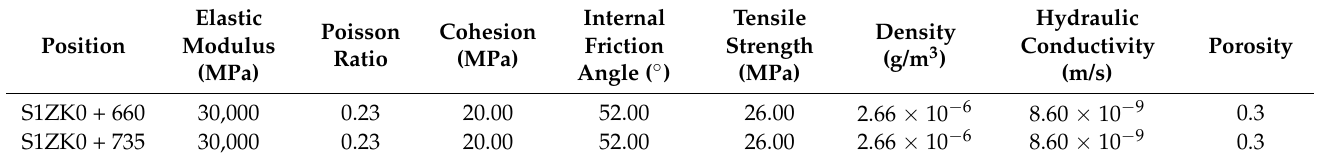
Table 1. Model geological parameters.